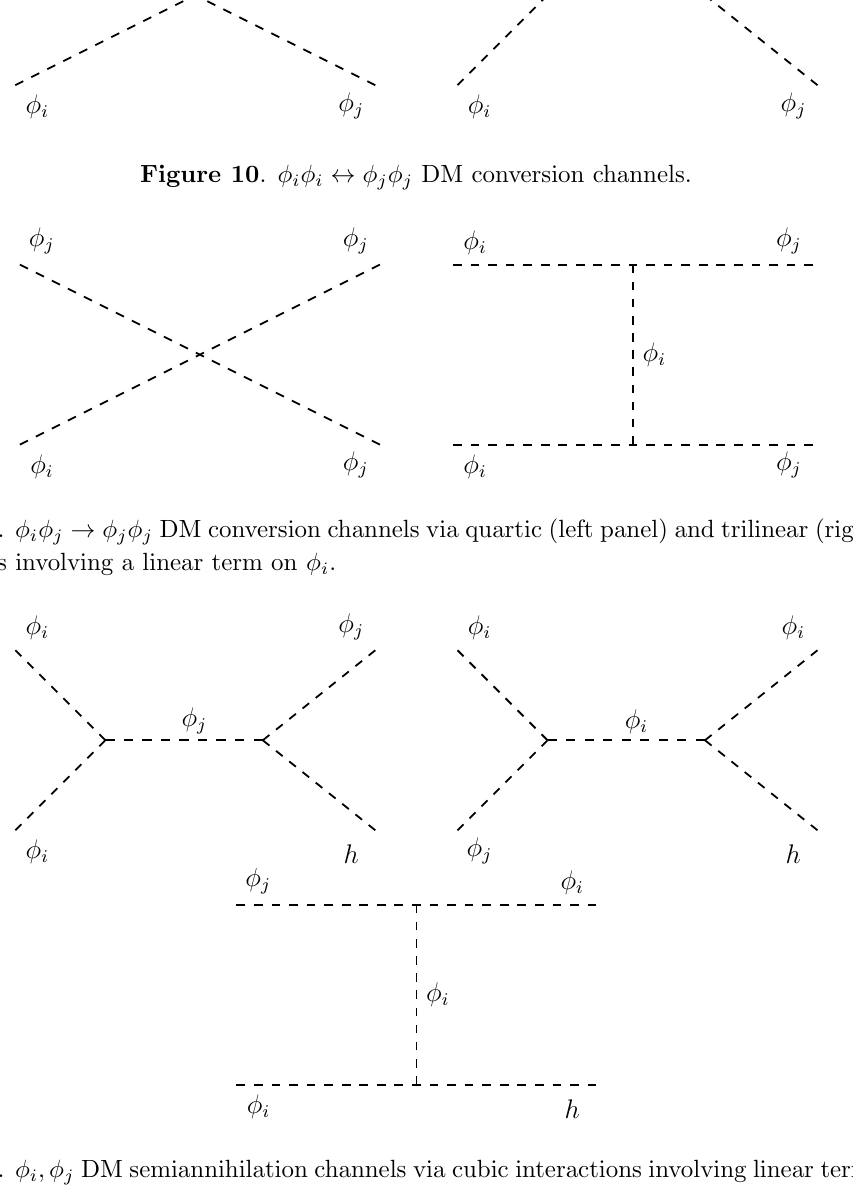
modify [33, 34] the typical outcome for the relic density of each DM particle from the standard freeze-out process